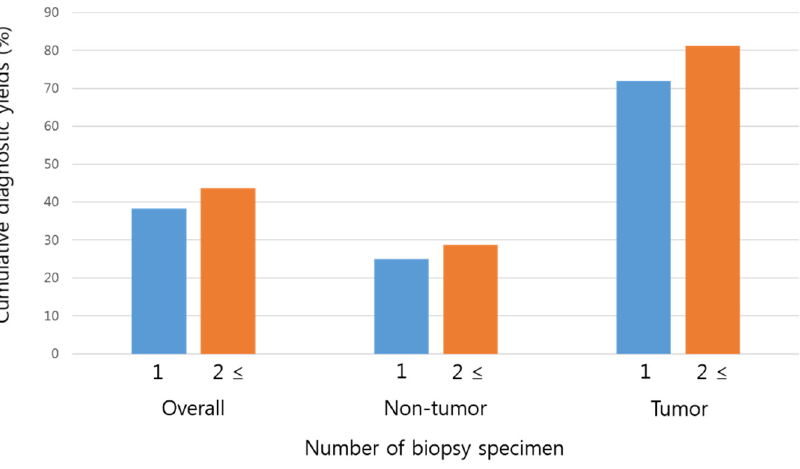
Figure 2. Cumulative diagnostic yields according to the number of serial enteroscopic biopsies.